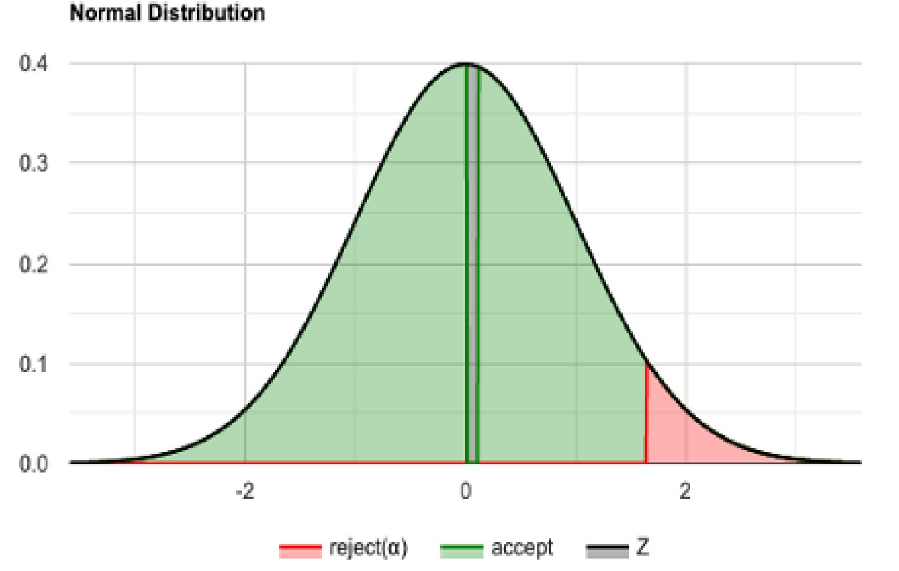
Fig 33. SA Sample: Normal distribution for n = 50 and N = 60.